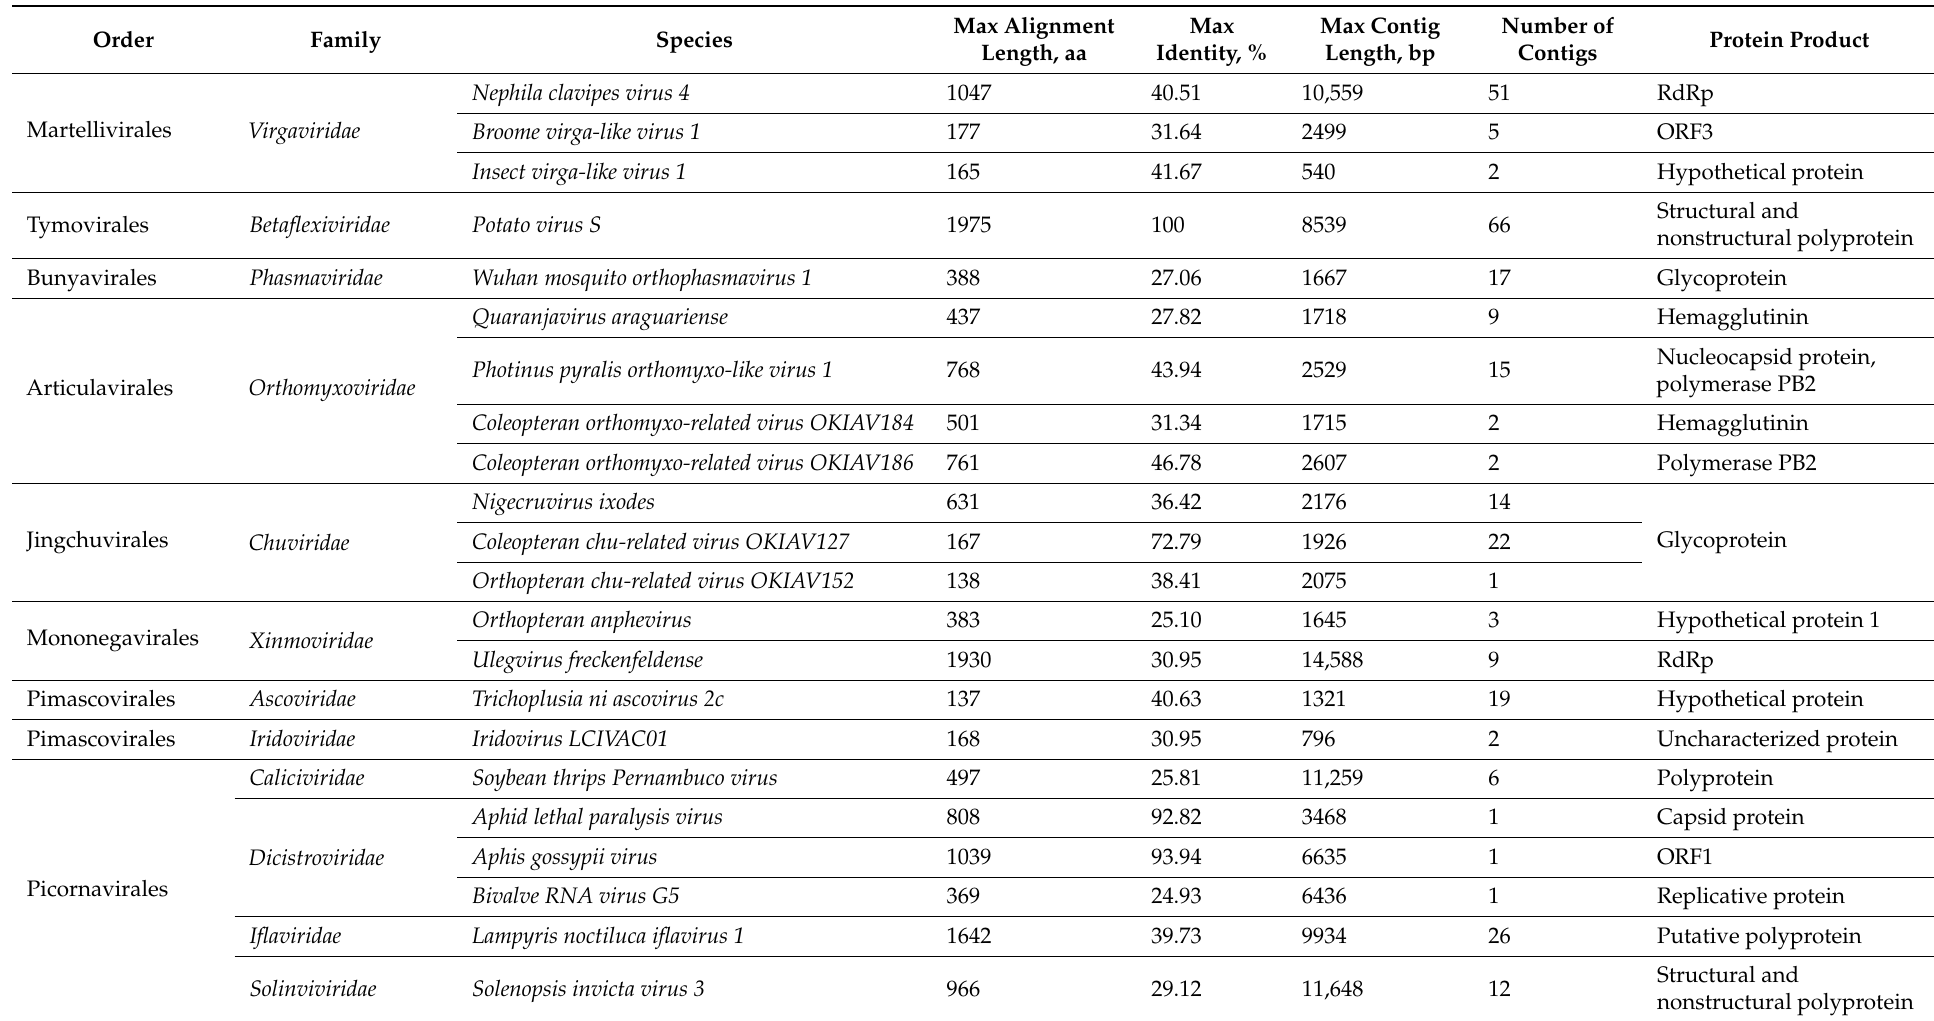
Table 1. The number of contigs by viral species, family, and order, with maximum alignment length, alignment identity percentage, and maximum contig length. The complete table is given in Supplementary Table S7 with project identifiers, protein products, extended taxonomy, and alignment e-values,